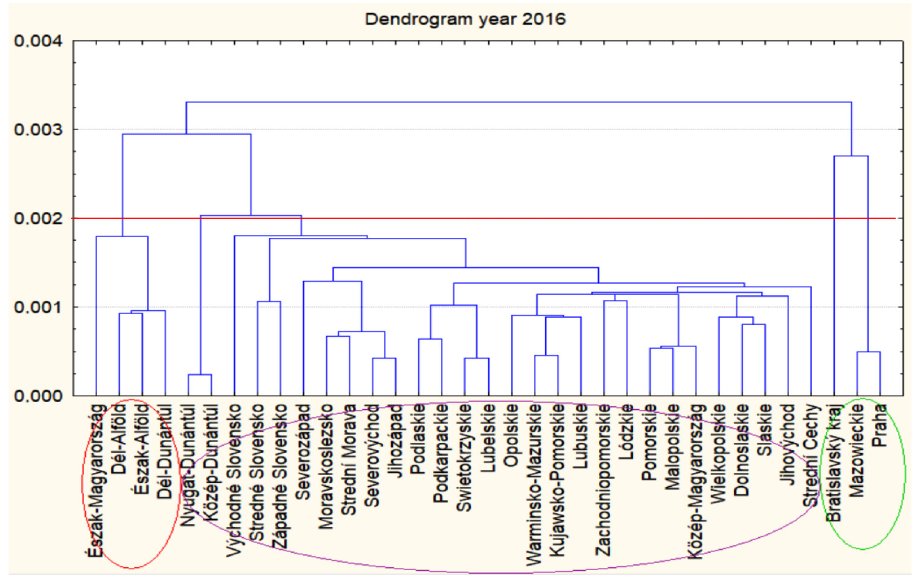
Figure 3. Dendrogram – year